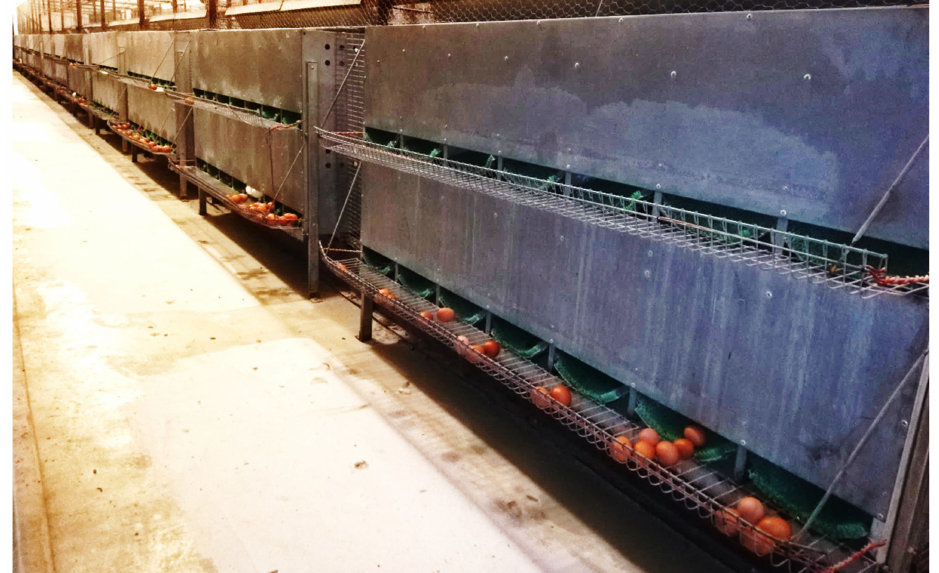
Figure 6. The significant preference for bottom nests in the Paternal